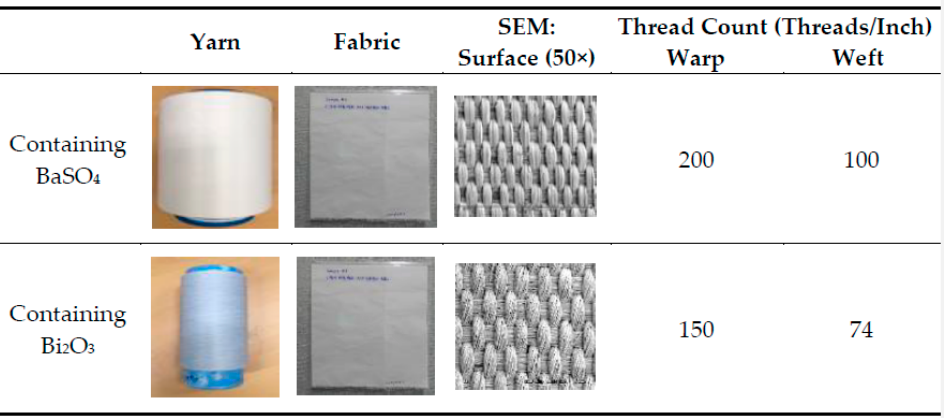
Figure 5. Radiation-shielding fiber yarn analysis: ( a ) results of energy-dispersive X-ray spectros- copy (EDS) analysis of yarn components, ( b ) cross-section SEM images (400×), and ( c ) surface SEM images (600×).